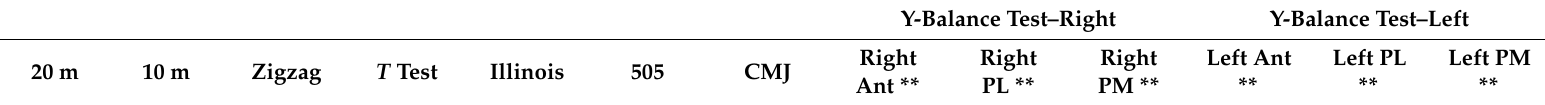
Table 2. Correlation test results in soccer HISP